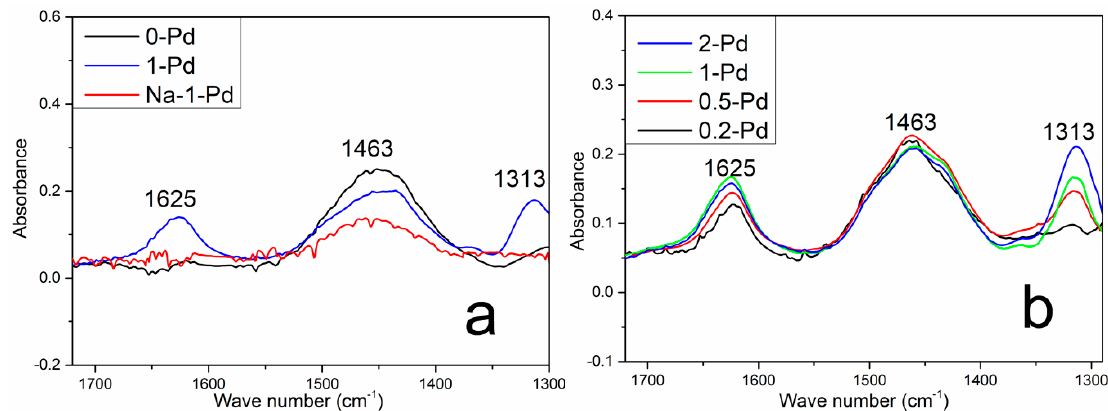
Figure 4. ( a ) NH 3 in situ FTIR spectra of 0-Pd, 1-Pd, Na-1-Pd; ( b ) NH 3 in situ FTIR spectra of 2-Pd, 1-Pd, 0.5-Pd, 0.2-Pd (Temperature: 80 °C; Flow: 500 ppm NH 3 , balanced with N 2 , 500 mL/min).